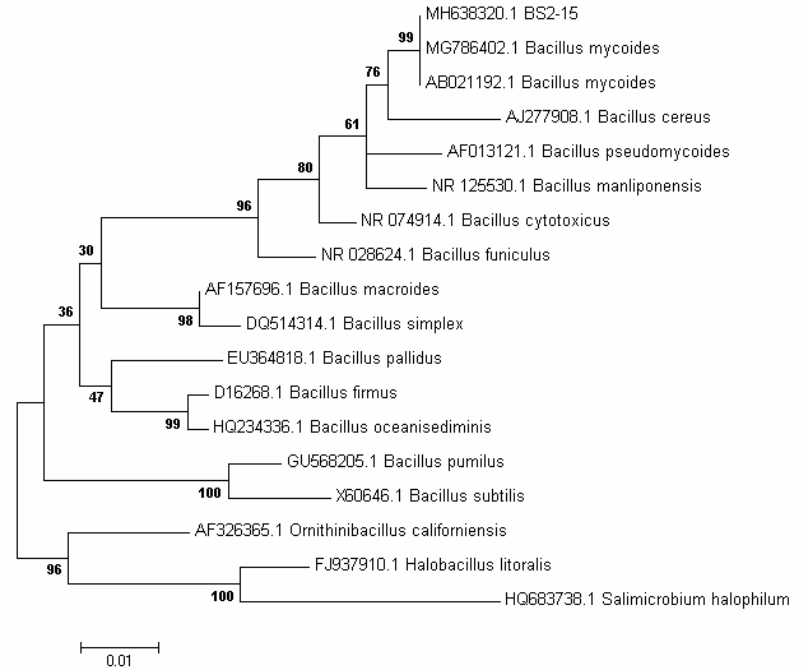
Figure 2. A phylogenetic tree for the algicidal strain BS2-15 and its closest BLAST hits was constructed using the Neighbor-Joining method of MEGA software (version 7.0), based on 16 rRNA sequences. Bootstrap supports are shown at the nodes.